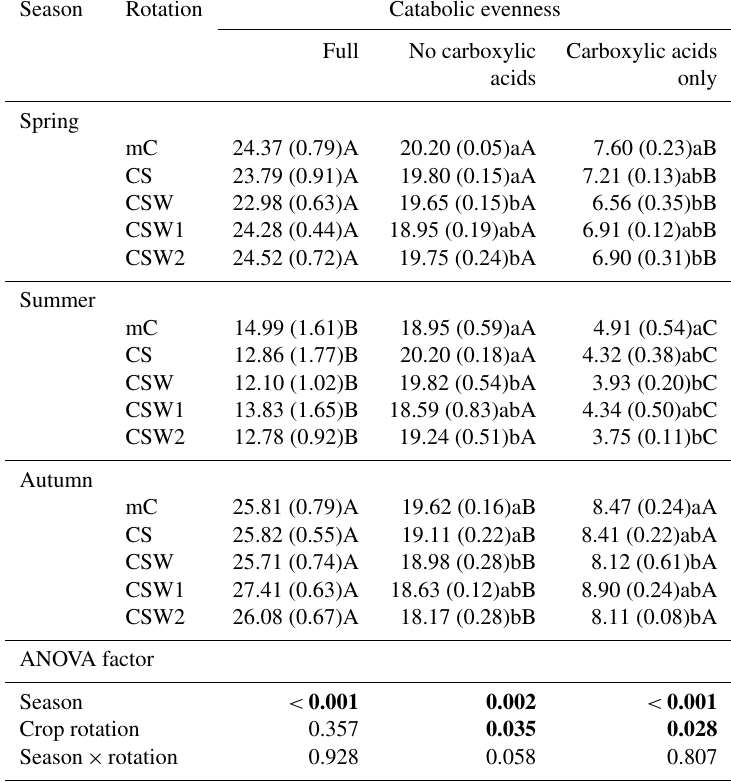
Note: see Table 1 for crop rotation abbreviations. Means ( n = 4) are shown with standard errors in parentheses. Significant comparisons ( P values in bold) are shown among rotations (lowercase) and season (capital) with